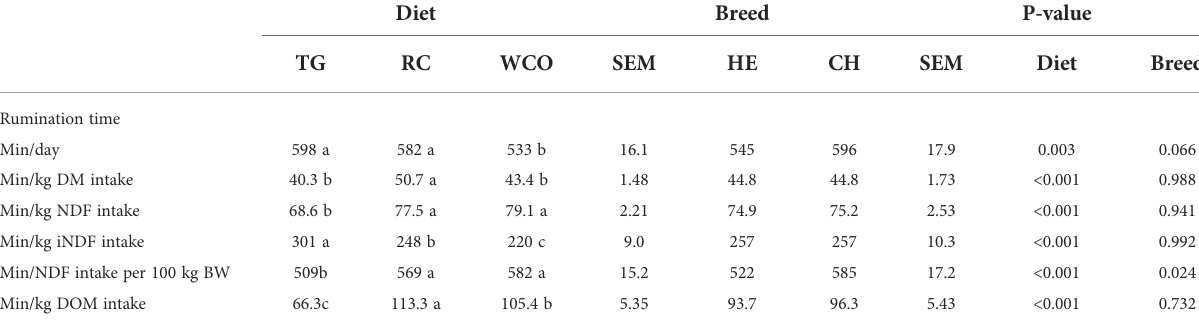
TABLE 1 Different ways to report the rumination time in beef cows of Hereford (HE) and Charolais (CH) breeds fed timothy silage (TG), reed canarygrass silage (RC), and whole-crop oat silage plus urea